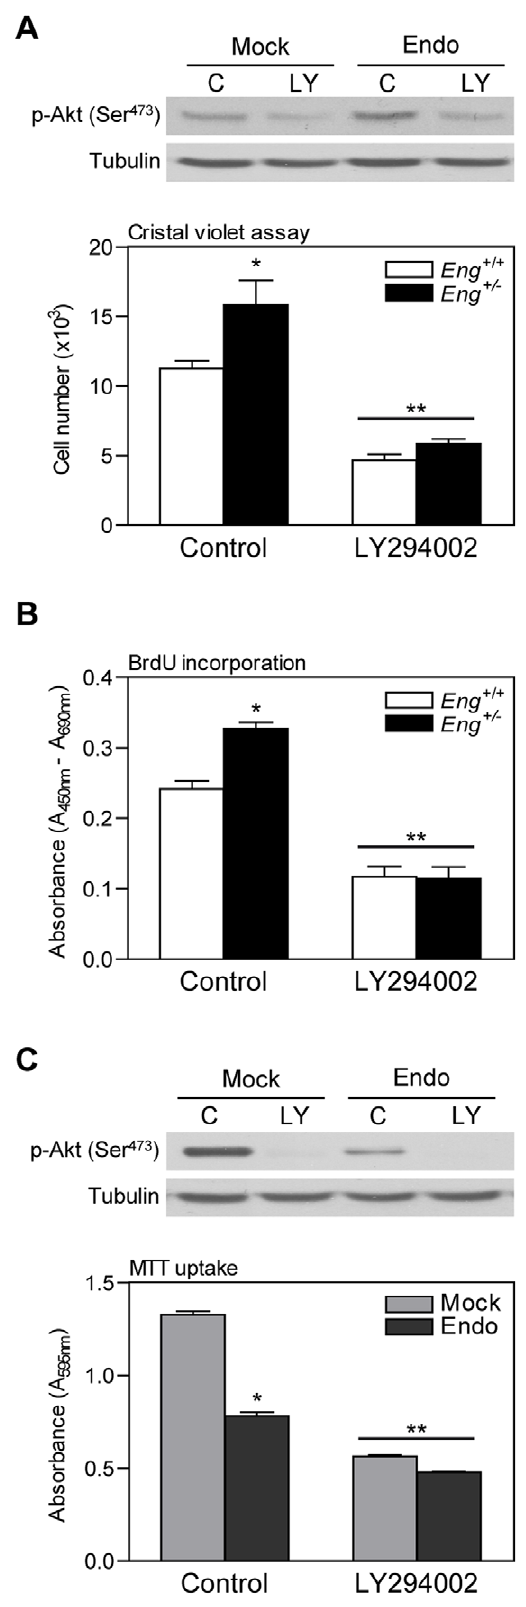
Figure 8. Effect of PI3K inhibition on endoglin-mediated different cell proliferation. ( A ) Cell number of MDF was analyzed by crystal violet assay after 10 m M LY294002 treatment for 4